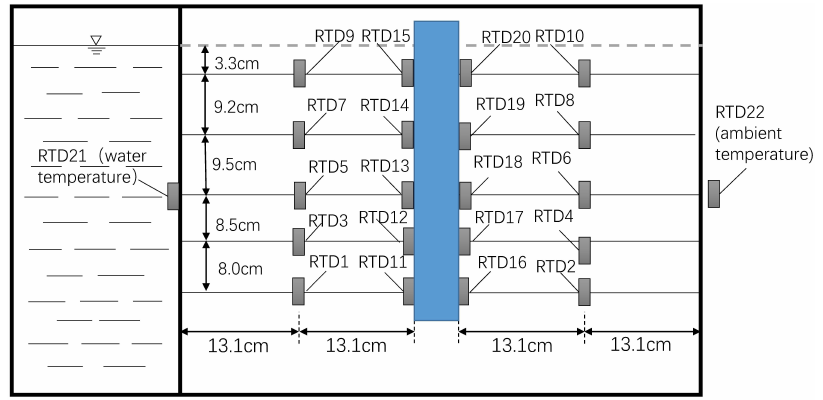
Figure 3. Layout of temperature